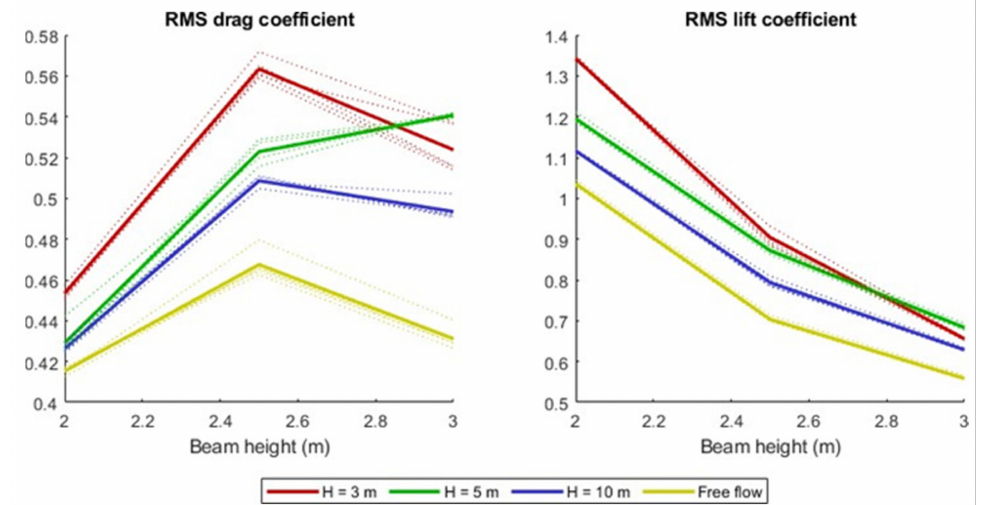
Figure 8. Root Mean Square (RMS) values of the drag and lift coefficients extracted from the simulations with one beam. The dotted lines represent the results for a particular wind speed, while the continuous lines are the average values from all the wind speeds (double column, B&W in the printed